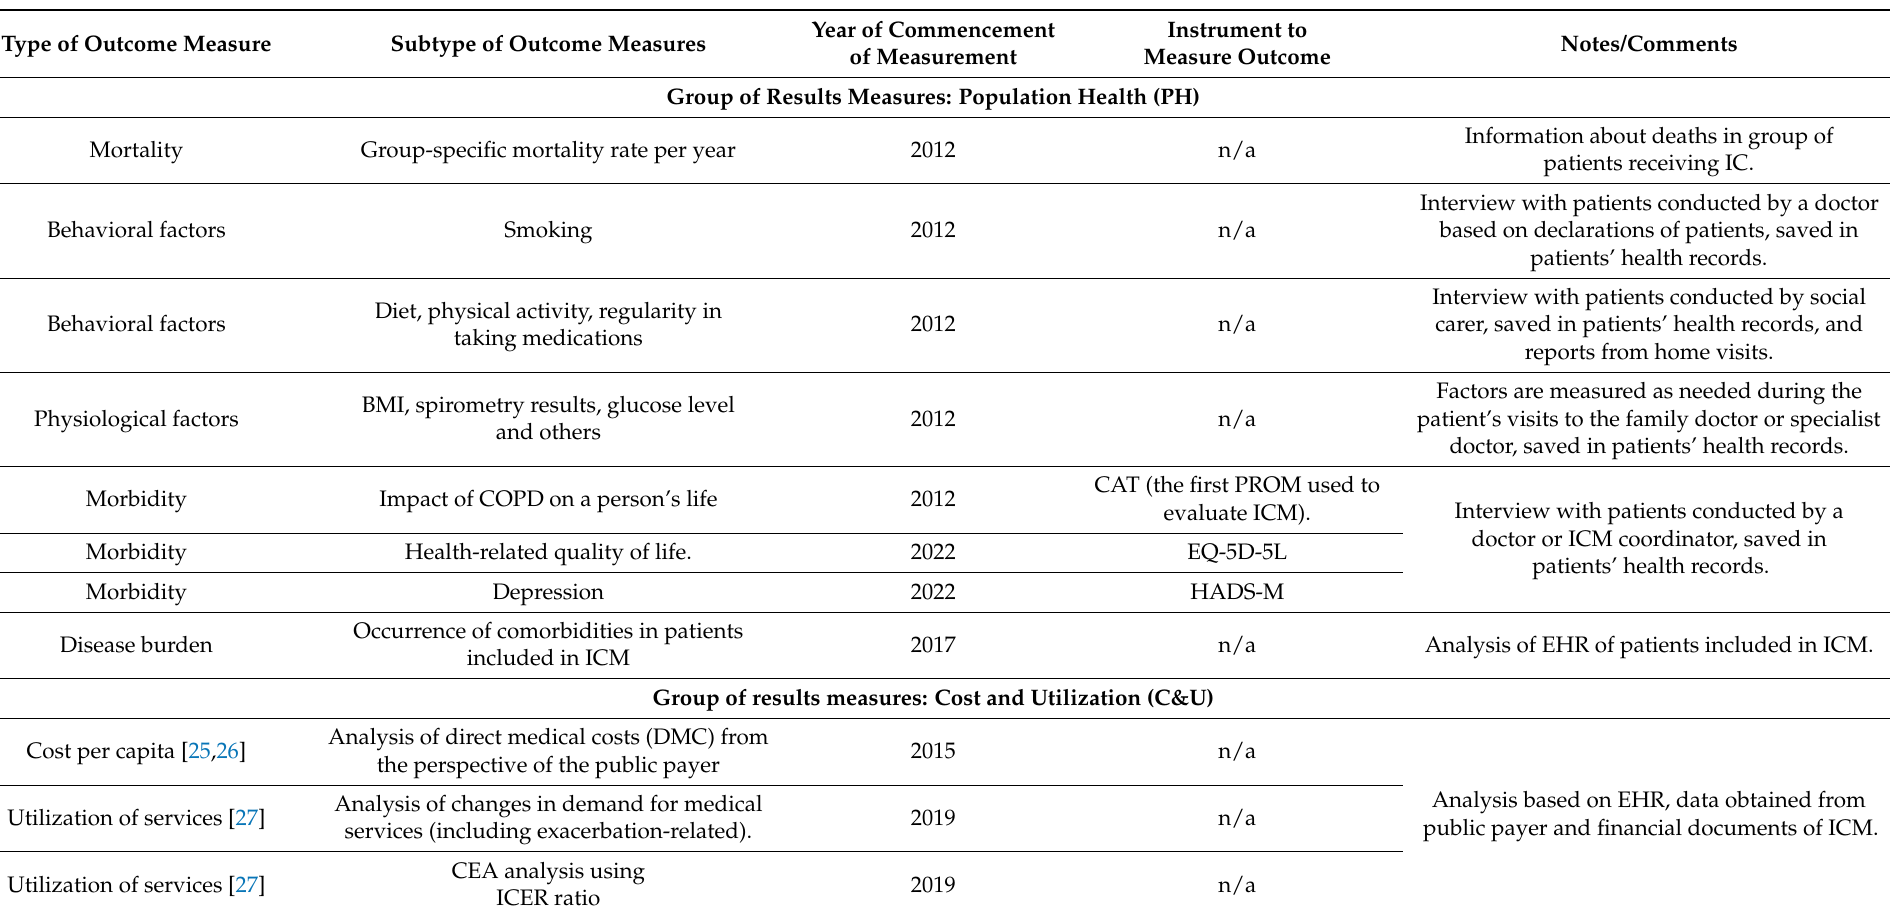
Table 1. Outcome measures used to evaluate the ICM within the first year of use and the type of instrument. Summary based on publications referring to ICM and internal ICM data